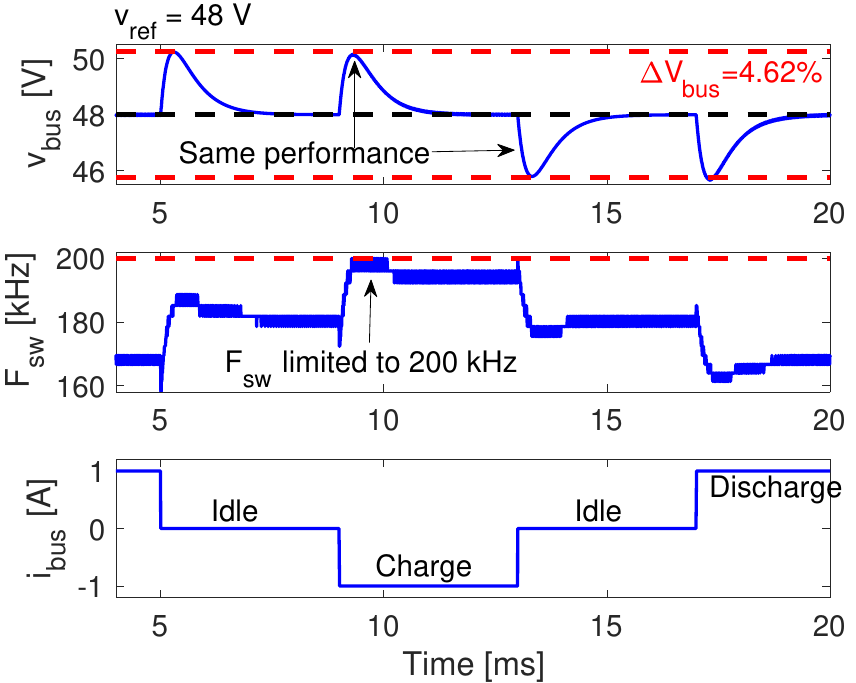
Figure 9. Operation under charge, idle, and discharge